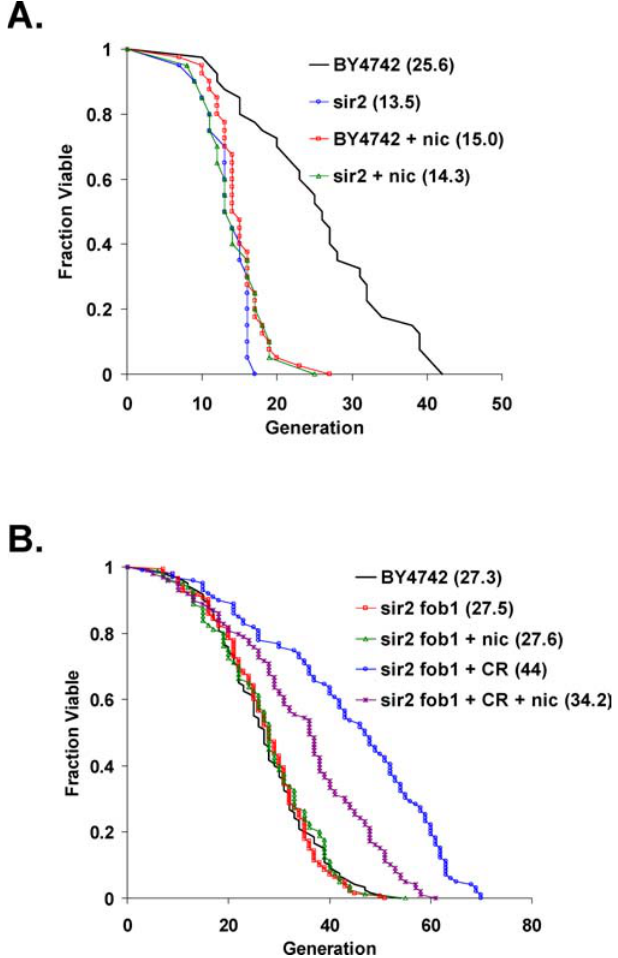
Figure 4. Effect of Nicotinamide on Life Span Extension by CR (A) Nicotinamide shortens the life span of wild-type cells. Replicative life span analysis for BY4742 wild-type and sir2 D cells on 2% glucose containing or lacking 5 mM nicotinamide (nic). Mean life span is shown in parentheses. (B) Nicotinamide partially prevents Sir2-independent life span extension by CR. Replicative life span analysis for BY4742 wild type on 2% glucose, along with sir2 D fob1 D double mutant cells on 2% glucose or 0.05% glucose (CR) containing or lacking 5 mM nicotinamide (nic). Mean life span is shown in parentheses. DOI: 10.1371/journal.pgen.0010069.g004